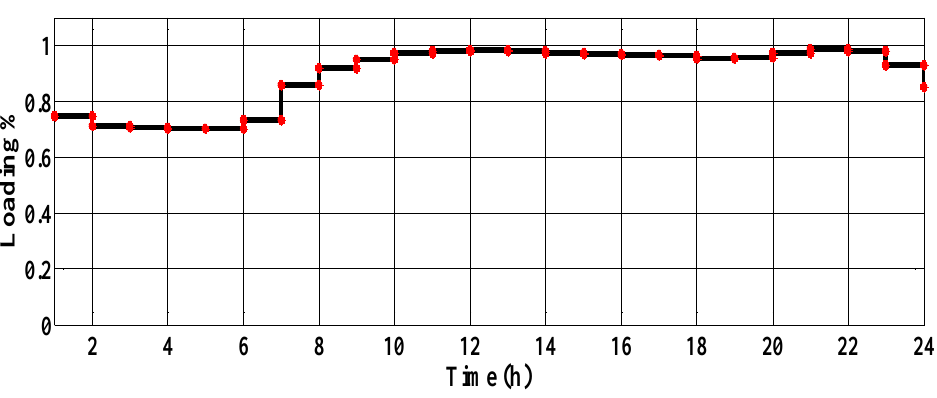
Figure 12. The gniTsacerof load profile.